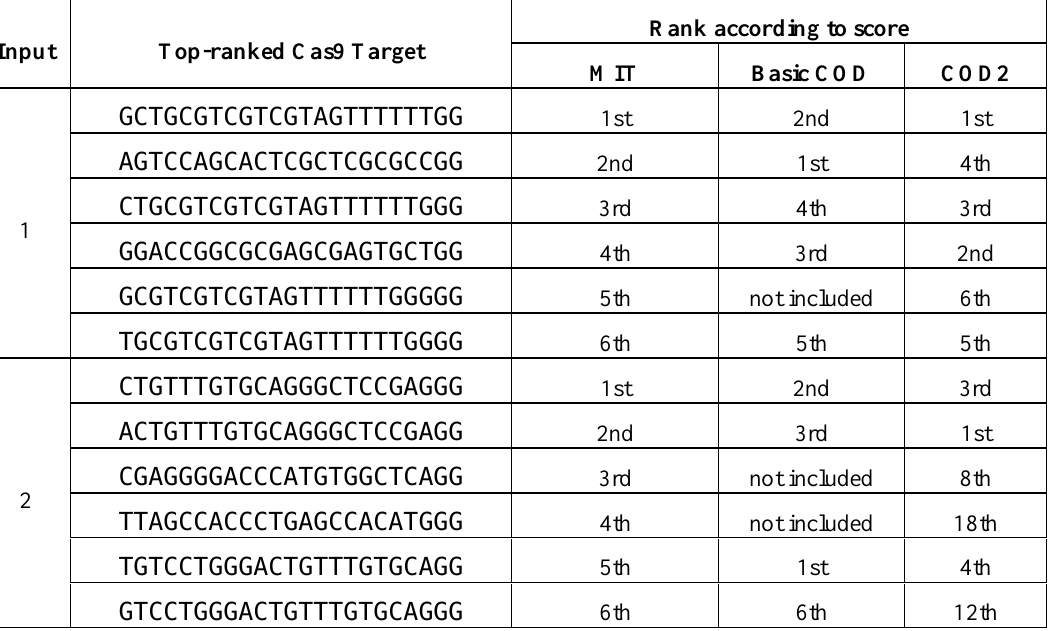
Table 2: MIT CRISPR, basic COD and COD2 designed similar sets of top-ranked Cas9 targets